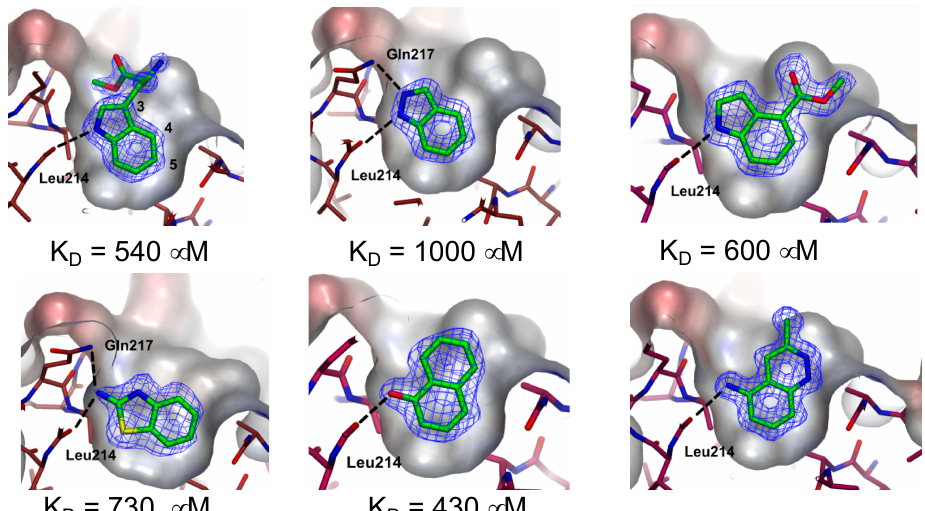
Figure 10. Crystal structures of fragments binding to the phenylalanine (F) pocket of RAD51 that mediates the RAD51–BRCA2 interaction during DNA homologous recombination. The micromolar a ffi nities of the individual fragments are given. Figure devised by Marko Hyvonen [95].